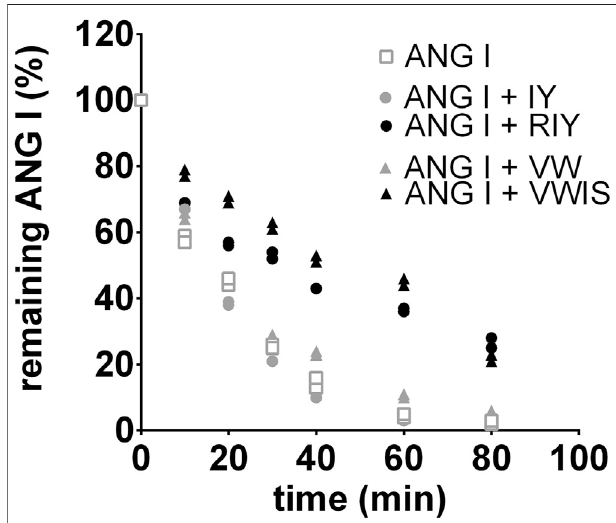
FIGURE 1 | Digestion of angiotensin I (ANG I) in human chymase solution.Thepeptidewasincubatedwiththeenzymefordifferenttimeperiods in the absence or presence of the inhibitory peptides and the remaining ANG I amounts were determined by reversed-phase high performance liquid chromatography. The results were independently repeated in a second experimentand wereusedtocalculatethehalf-lifetimeofANGIinabsenceor presence of inhibitory peptides (GraphPad Prism Software): T 1/2 (ANG I) (cid:1) 16 min; T 1/2 (ANG I + VW) (cid:1) 16 min; T 1/2 (ANG I + IY) (cid:1) 15 min; T 1/2 (ANG I + RIY) (cid:1) 24 min; T 1/2 (ANG I + VWIS) (cid:1) 56 min; the mean values were used for theanalysiswiththeSD. R 2 valuesranged from0.9679to0.9972.VW: valine- tryptophan, IY: isoleucine-tyrosine, RIY: arginine-isoleucine-tyrosine, VWIS: